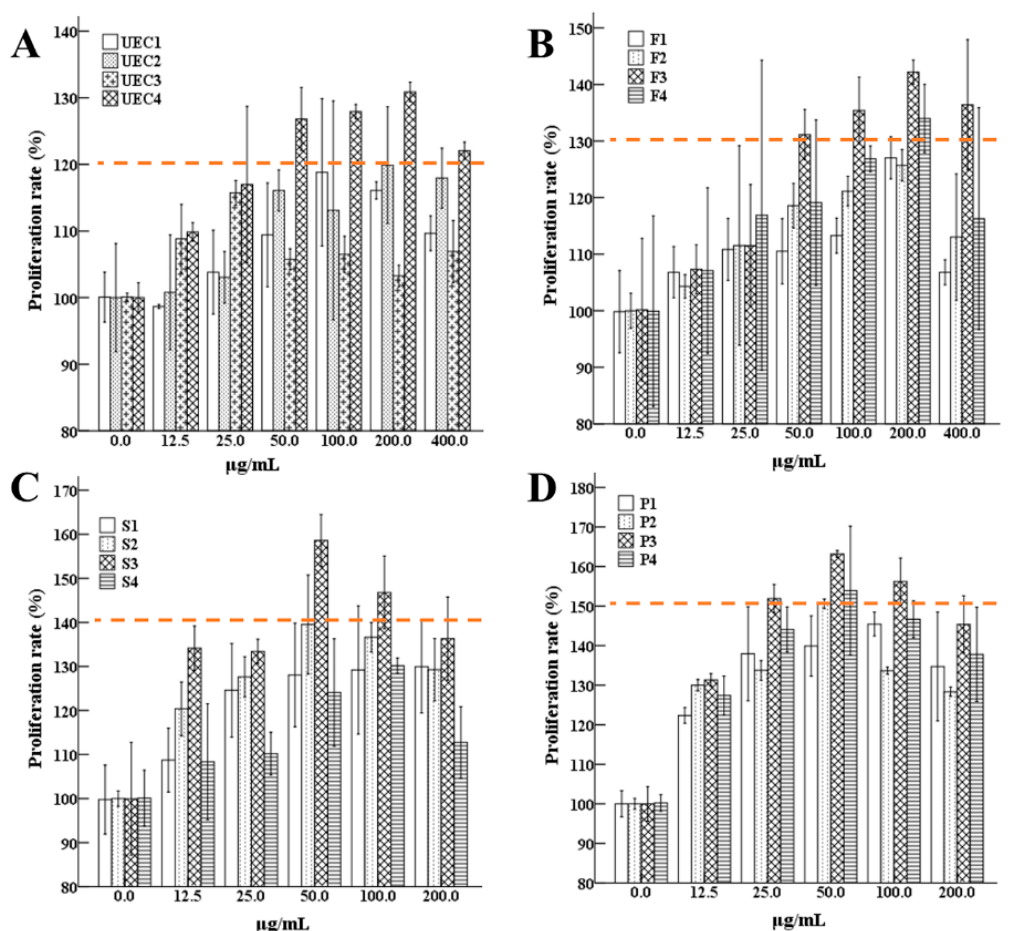
Figure 2. The proliferative effects of the isolated and purified components were evaluated. ( A ): Ultrafiltration fractions UEC1–UEC4; ( B ): fractions F1–F4; ( C ): fractions S1–S4; ( D ): fractions P1–P4.